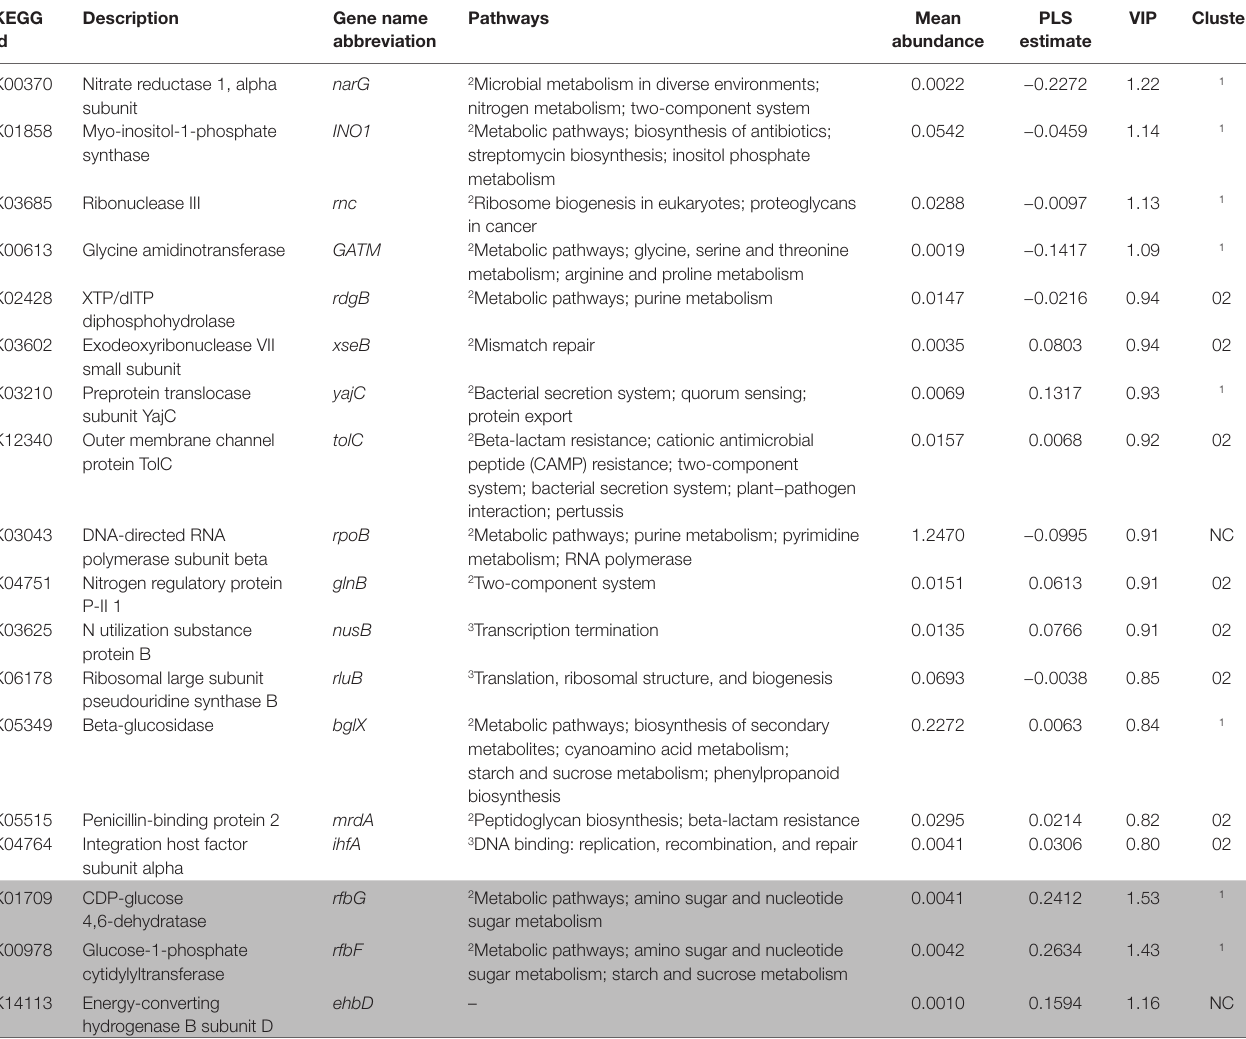
TABLE 5 | Summary of microbial genes identified for the prediction of DFI. KEGG id